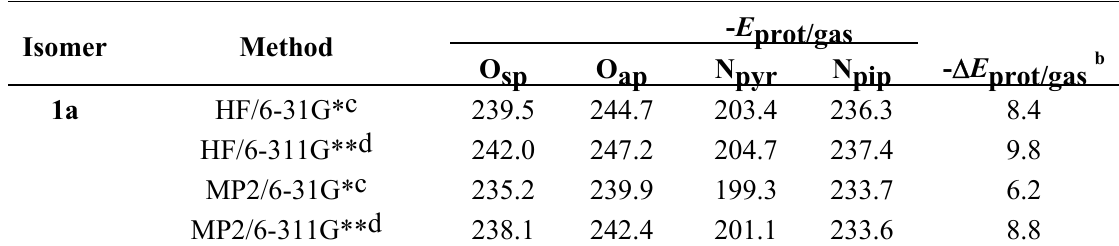
Table 2. Energies of protonation ( E prot/gas)a calculated for heteroatoms in